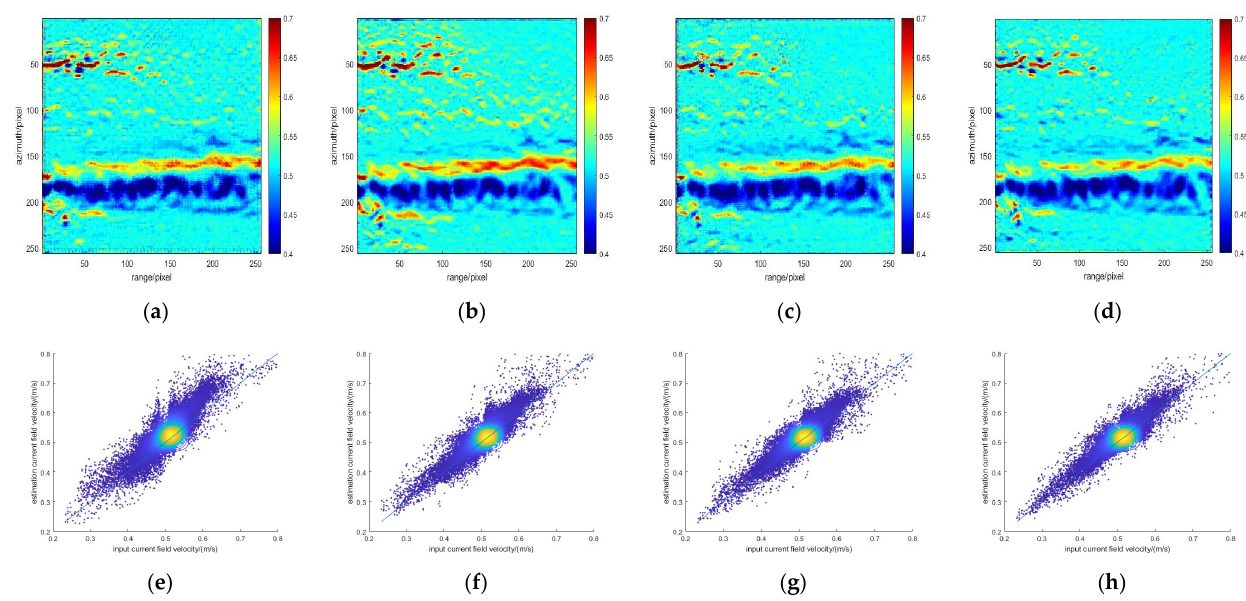
Figure 8. The estimation velocity of ocean surface currents under the different epochs from ( a – d ): ( a ) 100 epochs, ( b ) 200 epochs, ( c ) 300 epochs, and ( d ) 400 epochs. The scatter density map between the estimation velocity of ocean surface currents and the control group velocity of the input ocean surface currents under the different epochs from ( e – h ): ( e ) 100 epochs, ( f ) 200 epochs, ( g ) 300 epochs, and ( h ) 400 epochs. Table 4. Statistics of the estimation results under different epochs.